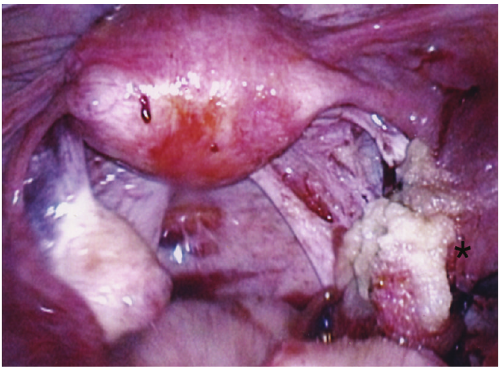
Figure 2: HSG reveals bilateral fallopian tube